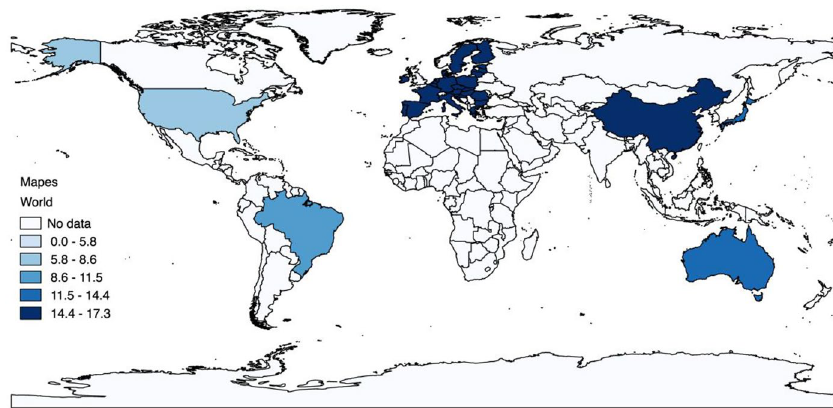
Fig. 1 Employment attributed to direct exports in relation to total employment (%), 2014. Source: Author’s calculations based on the WIOD